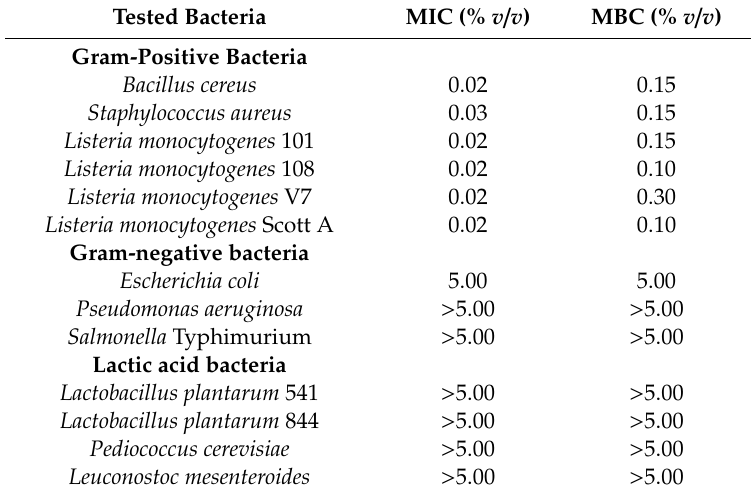
Table 2. The minimal inhibitory concentration (MIC) and minimal bactericidal concentration (MBC) values of EOEP against foodborne microorganisms determined by broth dilution